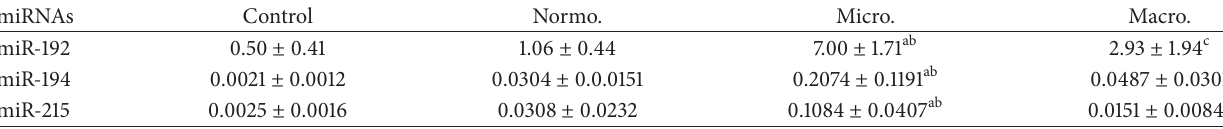
Table 2: Levels of miRNAs in urinary EVs between groups.